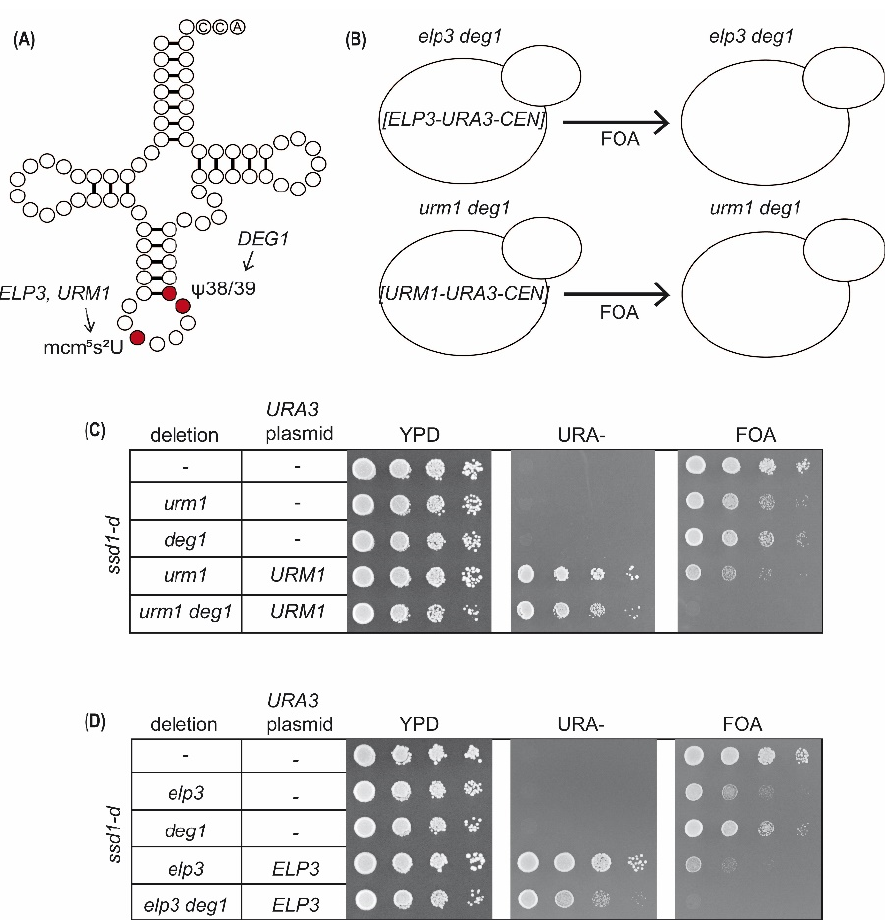
Figure 3. Plasmid shuffle assay to determine genetic interaction between DEG1 and ELP3 or URM1 in the ssd1-d strain. ( A ) Scheme indicating position and required genes for mcm 5 s 2 U 34 and Ψ 38/39 modifications in tRNA. ( B ) Principle of plasmid shuffle assay involving elp3 deg1 or urm1 deg1 double mutants carrying URA3-CEN plasmids that provide for ELP3 or URM1 wild-type gene functions, respectively. 5-FOA medium (FOA) counterselects against the URA3 -based plasmids and thus uncovers the double mutant phenotype. ( C ) Result of plasmid shuffle assay in the deg1 urm1 strain. ( D ) Result of plasmid shuffle assay in the deg1 elp3 strain. WT and indicated mutants with and without URA3 -based plasmids were serially diluted and spotted on YPD, URA, and FOA plates. YPD and URA plates were incubated for 48 h, and FOA plates were incubated for 72 h at 30 ◦ C. Negative growth phenotypes of SSD1-v deg1 urm1 and deg1 elp3 double mutant strains were previously shown to be partially suppressible by the overexpression of tRNA GlnUUG [7]. A functional defect of this tRNA is thought to account for the negative phenotypes of the double mutants, and the higher-than-normal levels of the defective tRNA can likely compensate for functional impairment. To test whether the synthetic lethal interaction between elp3/urm1 and deg1 in the ssd1-d background can similarly be suppressed, we repeated the plasmid shuffle approach shown in Figure 3 in the presence of an overexpression construct for tRNA Gln UUG or an appropriate empty vector control.